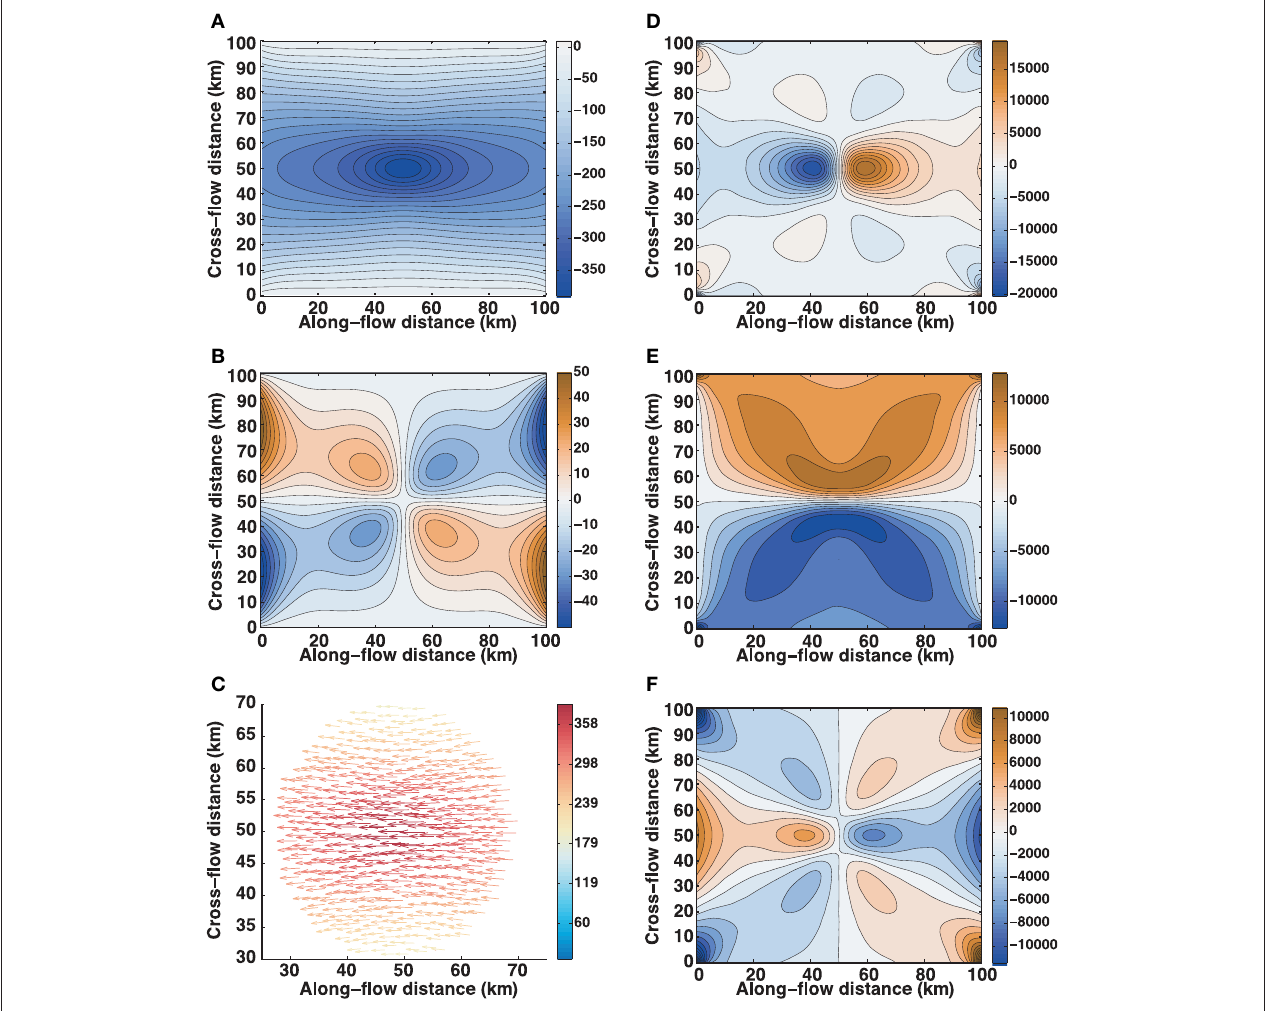
FIGURE 2 | Perturbation at t = 12 h: (A) along-flow velocity; (B) cross-flow velocity; (C) vector velocity (colored by magnitude) within 20 km of sticky-spot center; (D) along-flow stress; (E) shear stress; (F) cross-flow stress. Velocities in m a − 1 , stresses in Pa. Mean velocity is from left to right in the positive along-flow